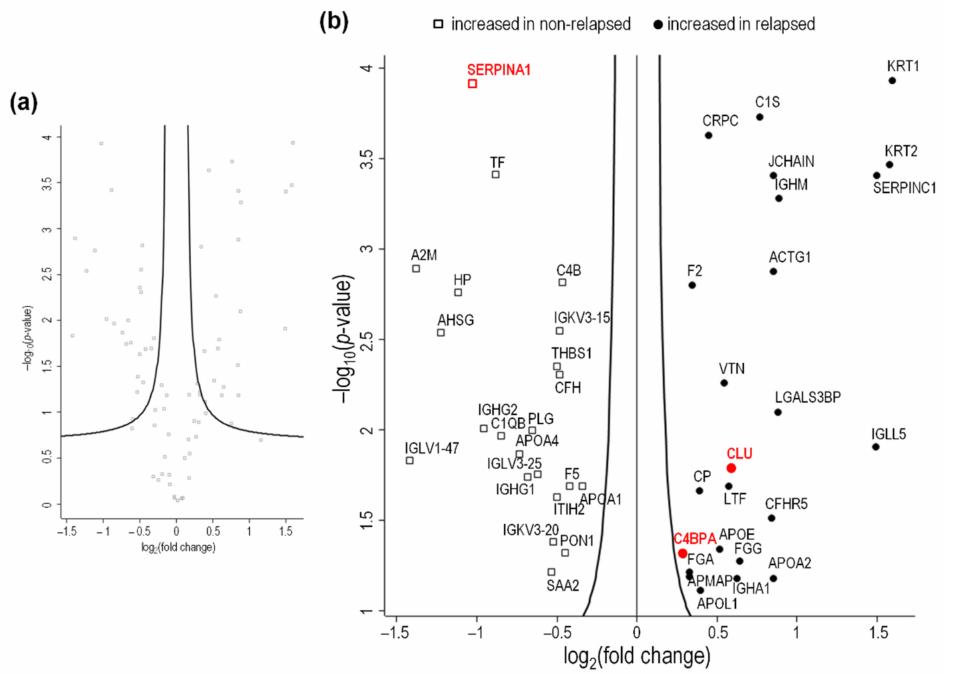
Figure 2. Volcano plot showing proteomic data by HL status (relapsing vs. non-relapsing) in the exploratory cohort. Log2 transformed abundance ratios for each protein are plotted on the x -axis. Negative log10 transformed p -values are plotted on the y -axis. The 107 proteins identified and quantified are shown in grey in ( a ). Among them, there were 24 proteins (circles) significantly more abundant, and 22 (squares) less abundant in patients whose HL relapsed than in non-relapsing patients ( b ). Proteins selected in Part II are evidenced in